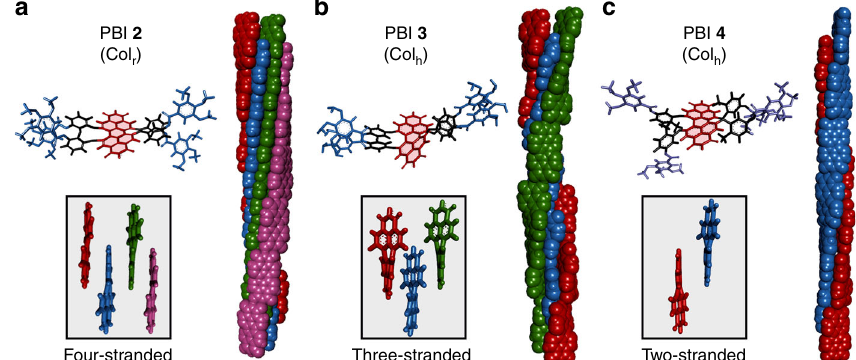
Fig. 4 Optimized self-assembled structures of PBIs 2 , 3 , and 4 . Geometry-optimized monomers, tetramers/trimers/dimers, and four-/three-/two-stranded helices of PBI 2 ( a ), 3 ( b ), and 4 ( c ), respectively. The helicity in the columnar assemblies has been chosen to be (P) for graphical representation. Please note that PBIs 1 – 4 are racemic and therefore (P) and (M) helices may coexist in the LC phases